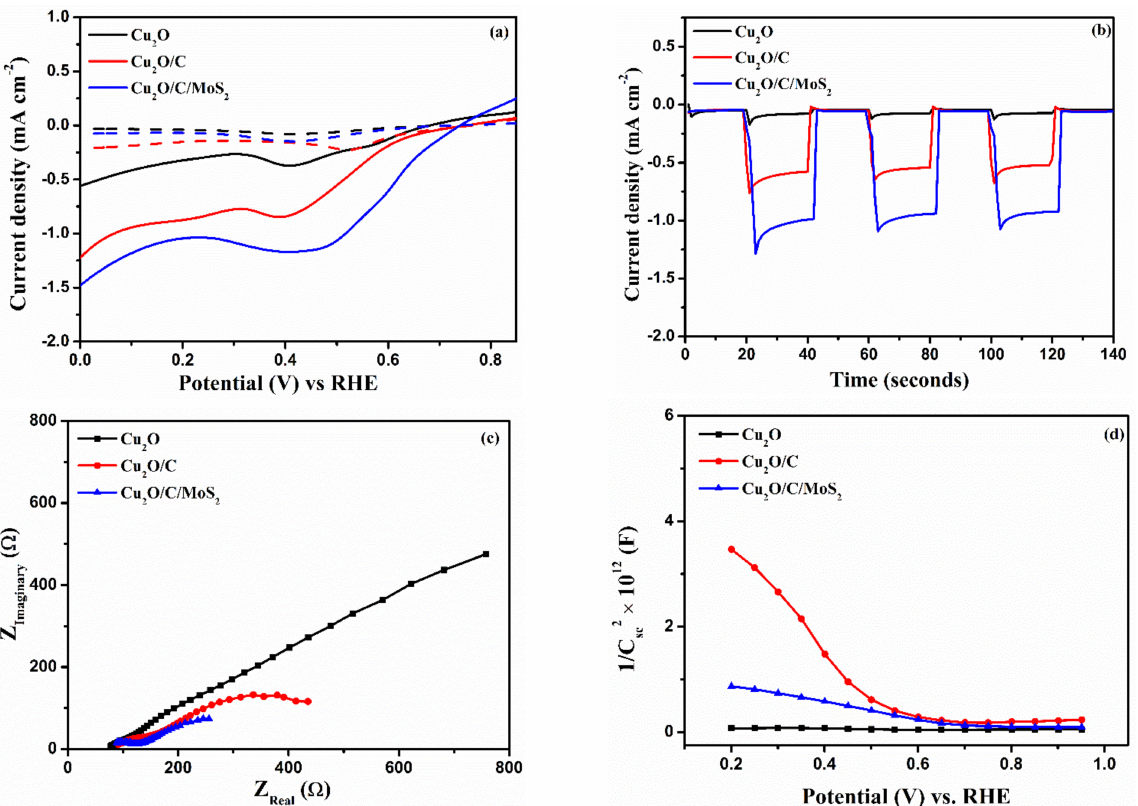
Figure 5. ( a ) Linear sweep voltammetry (LSV), ( b ) J vs. t at 0 V vs. RHE, ( c ) Electrochemical impedance spectroscopy (EIS), and ( d ) Mott–Schottky of Cu 2 O/C and Cu 2 O/C/MoS 2 photocathodes using an AM 1.5 G illumination source with a power intensity of 100 mW cm − 2 .